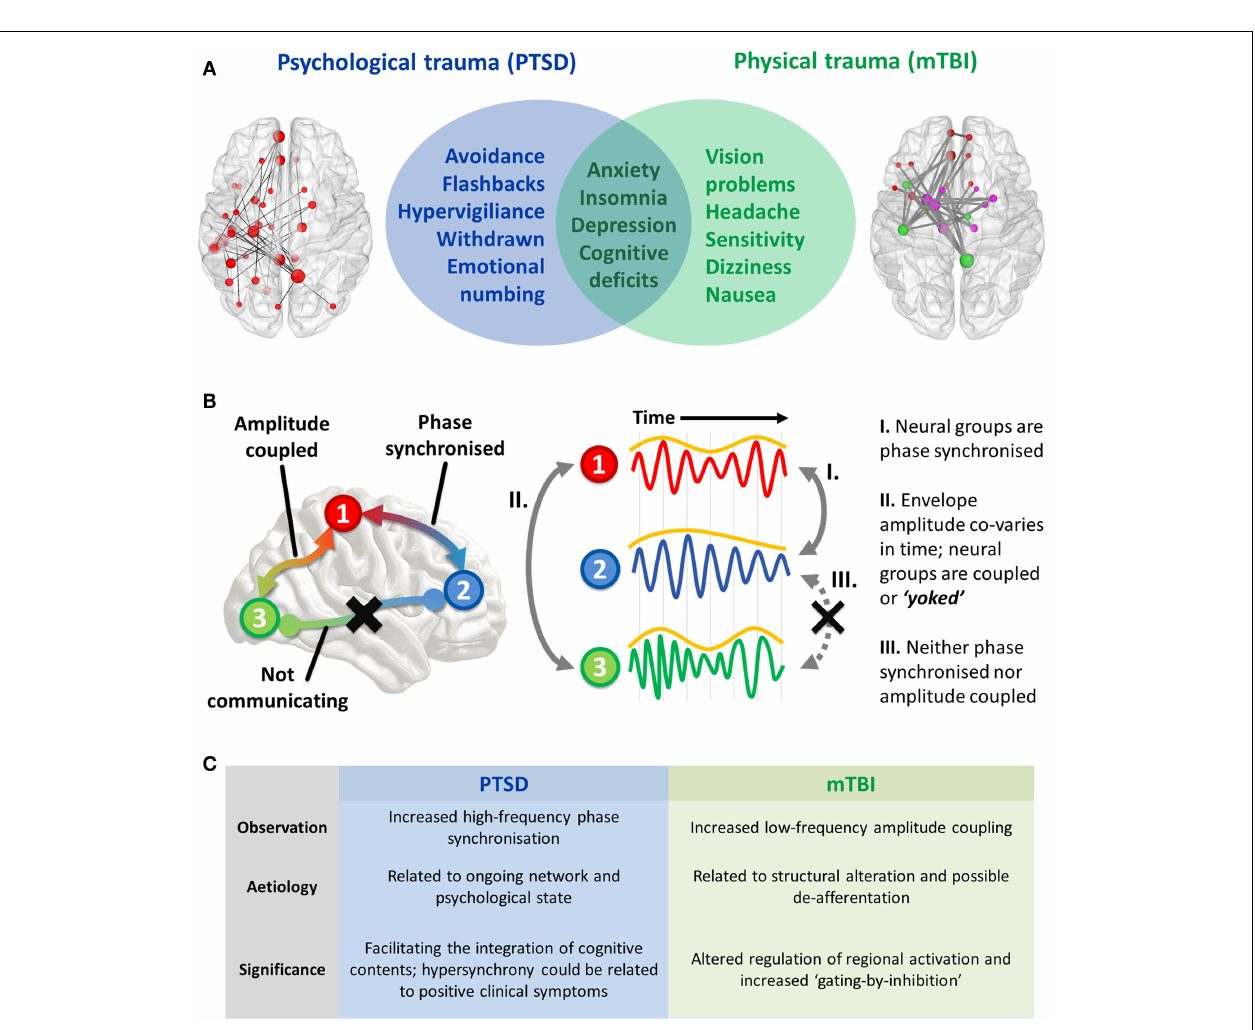
FIGURE 1 | (A) Interface of PTSD and mTBI symptomatology, and empirical evidence of altered spontaneous functional connectivity patterns in a resting-state paradigm. Both patient groups show elevated connectivity compared to their respective control groups, with increased coupling in PTSD mediated by high-frequency (high gamma-range, 80–150Hz) oscillatory synchronization; in the mTBI group connectivity is enhanced in the low-frequency range (delta–theta range, 1–3 and 3–7Hz), and is typified by envelope amplitude cross-correlations/temporal covariations. (B) Hypothesized role of coupled oscillators in interregional brain communication, and the distinct mechanisms of “intrinsic coupling modes.” These are divided into phase ICMs (facilitating communication between regions 1 and 2, described in I), and envelope ICMs (regulating temporally coordinated activity between regions 2 and 3, described in II). In contrast to these mechanisms, regions 1 and 3 are neither phase synchronized nor amplitude coupled, and therefore communication is suppressed between these regions. (C) Summary of findings and the theorized phenomenological significance of these atypical connectivity patterns.